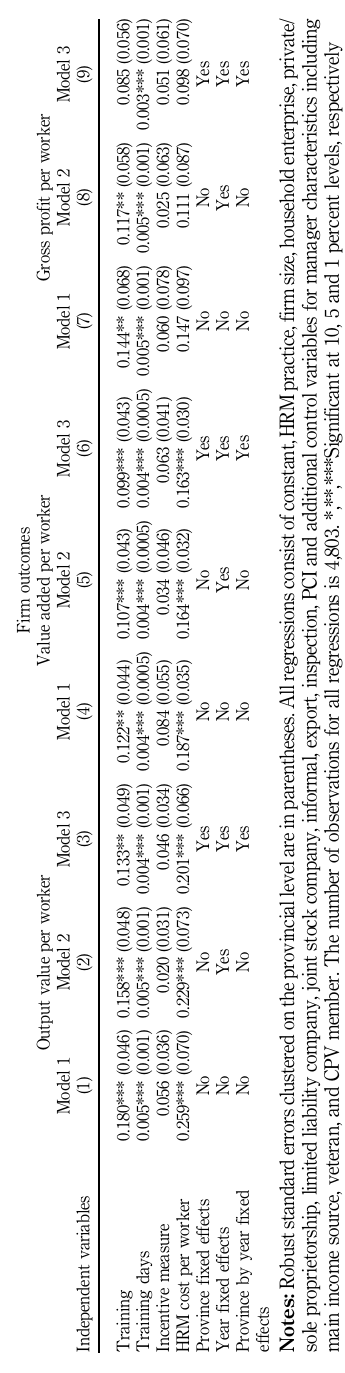
Table VI. Further